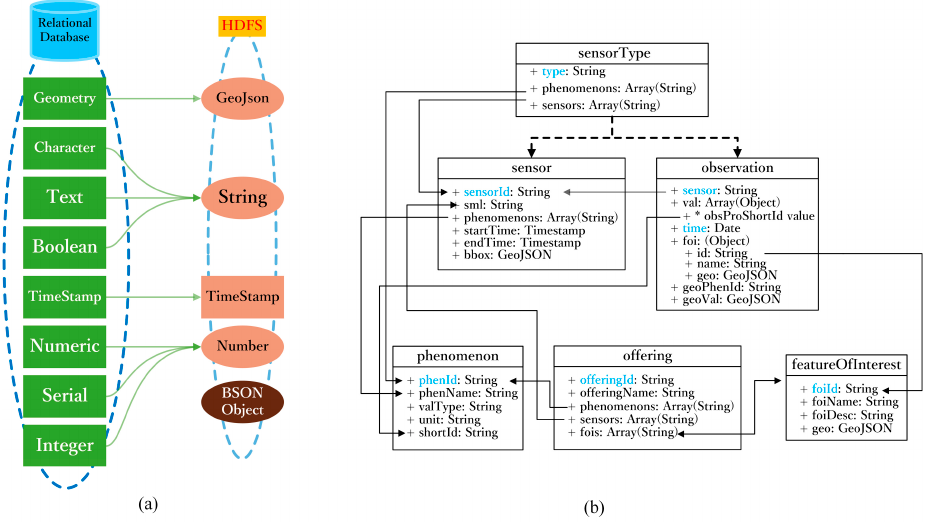
sensorType table: Stores the sensor type information of the sensors and phenomenon. sensor table: Stores the sensor information, including the sensor metadata, the time when the sensor begins observation and the time when the sensor ends observation. observation table: Stores the observation information when the sensors finishes observation, including the observation time, spatial range of the observation and the observation result. phenomenon table: Stores the phenomenon information, including the phenomenon name, observation value type and unit information. offering table: Stores the organization information, including the organization name, phenomenon name and sensor information.